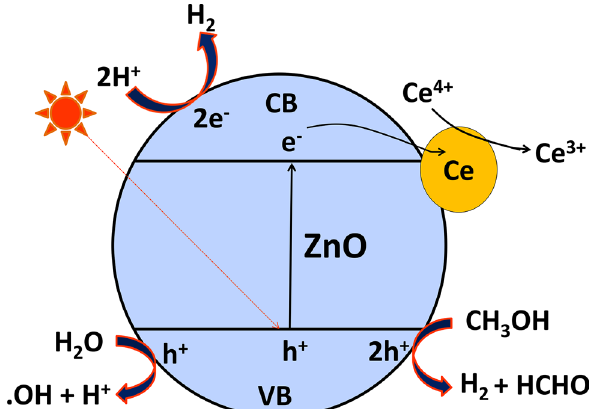
Fig. 10 Possible mechanism of photocatalytic H